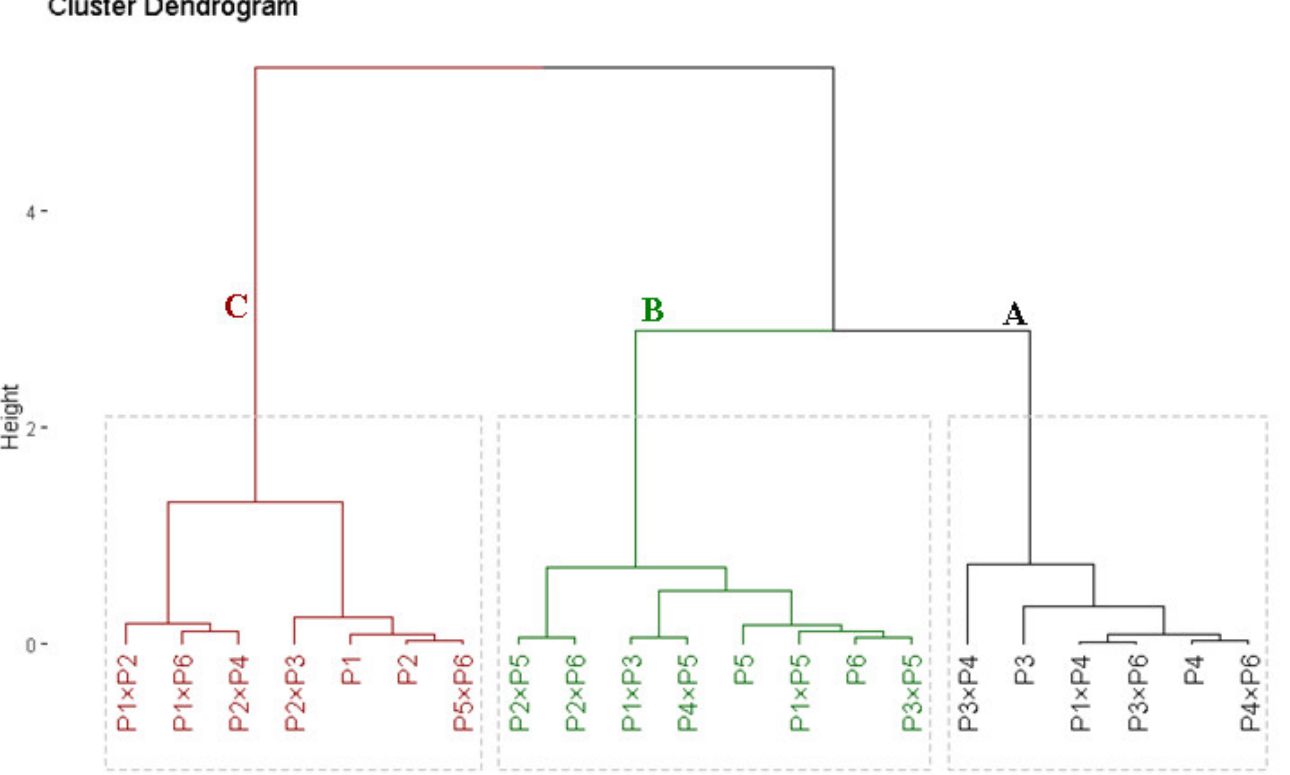
Figure 4. Dendrogram of the phenotypic distances among six rice genotypes and their 15 corresponding crosses based on four drought tolerance indices. The genotypes were categorized into three groups: A is drought-tolerant; B is moderately drought-tolerant; and C is drought-sensitive.